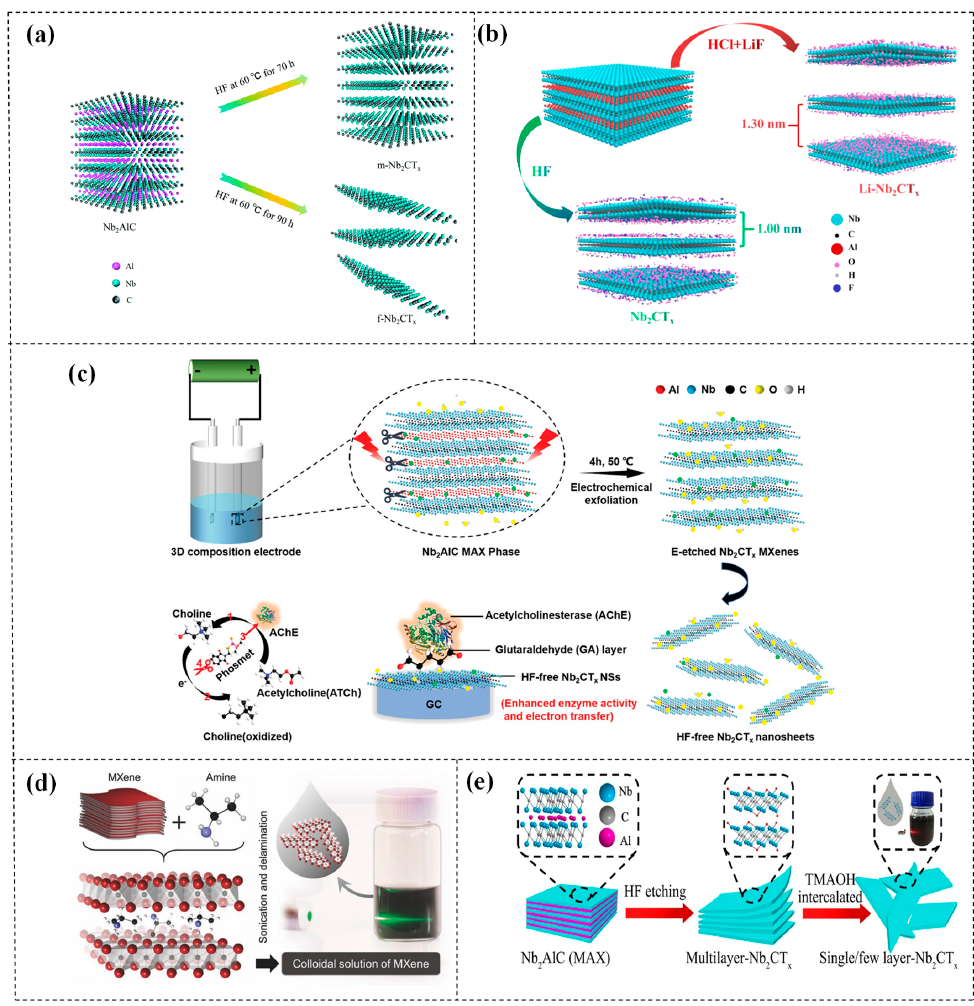
Figure 3. Synthesis and delamination of Nb 2 CT x . ( a ) Synthesis of Nb 2 CT x using HF etching